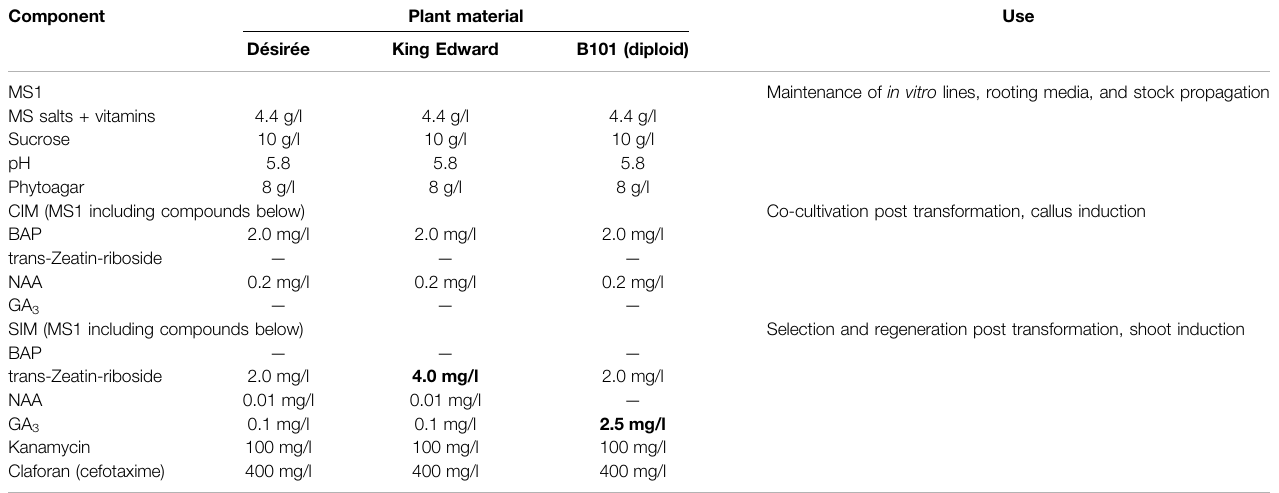
TABLE 1 | Media Composition for the maintenance, transformation, selection, and regeneration of the potato genotypes Désirée, King Edward, and B101 (diploid). CIM = callus induction media; SIM = shoot induction media.